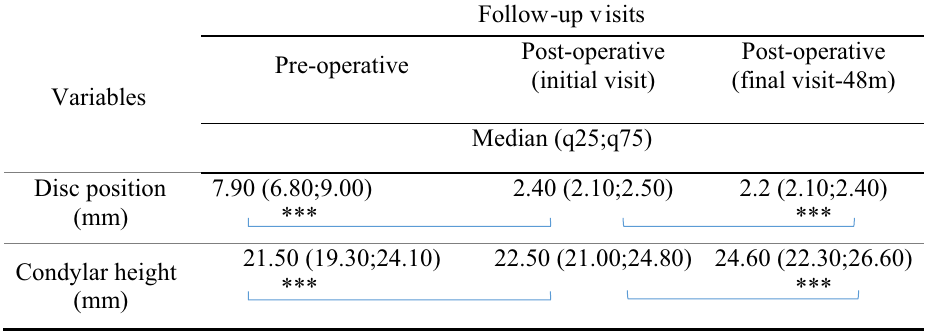
Table 4. Changes in disc position and condylar height pre- and postoperatively. *** p < 0.001 (Wilcoxon signed ranked test).